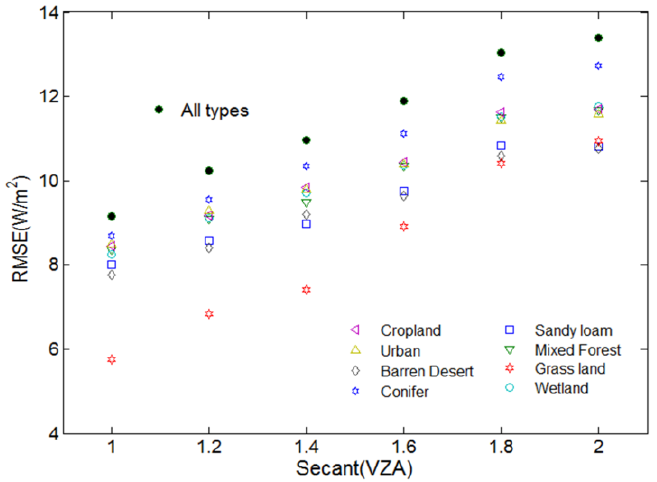
Figure 7. Root mean square error (RMSE) between the actual downwelling surface longwave radiation (DSLR) and the DSLR estimated using the proposed models for different surface types from VZA = 0° to VZA = 60° when surface altitude z = 0 km.